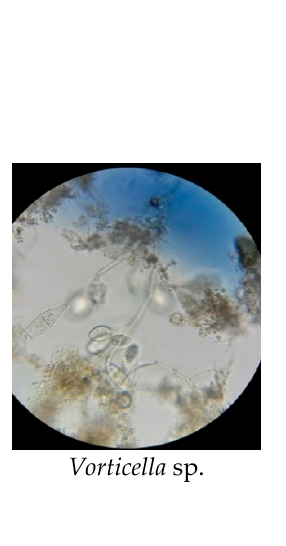
Figure 4. Microscopic image of aerobic microorganisms (magnification 100 × ).